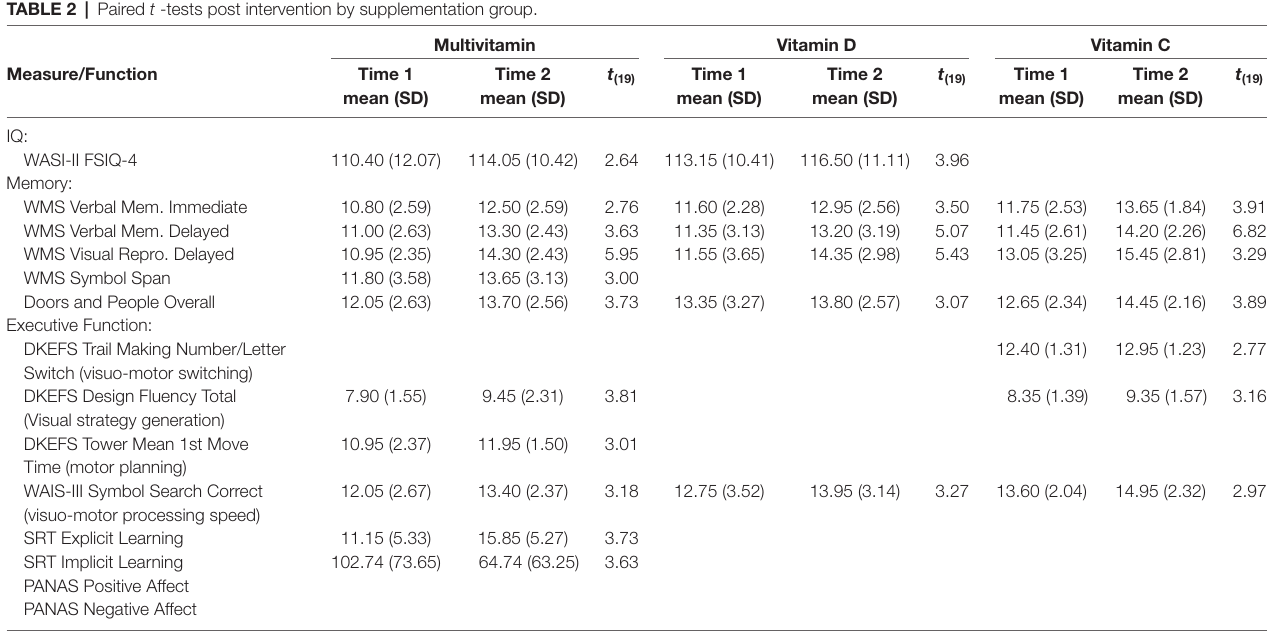
TABLE 2 | Paired t -tests post intervention by supplementation group.